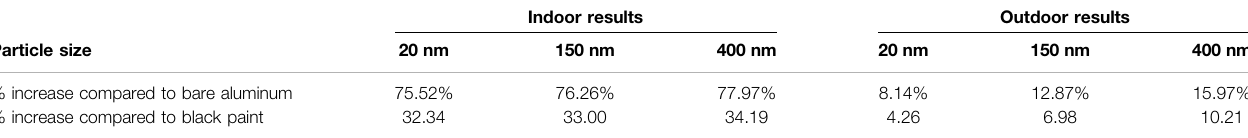
TABLE 3 | Comparative percentage increase in